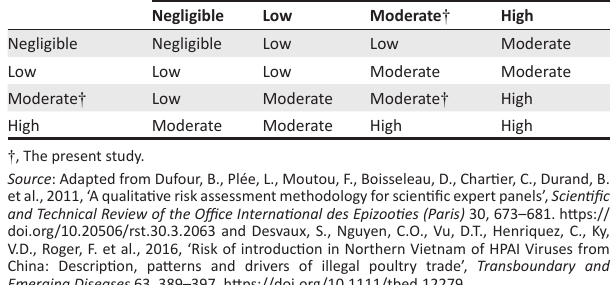
TABLE 2: Combination risk matrix of the likelihood of exposure and entry of Leishmania and the consequence assessment. Consequence